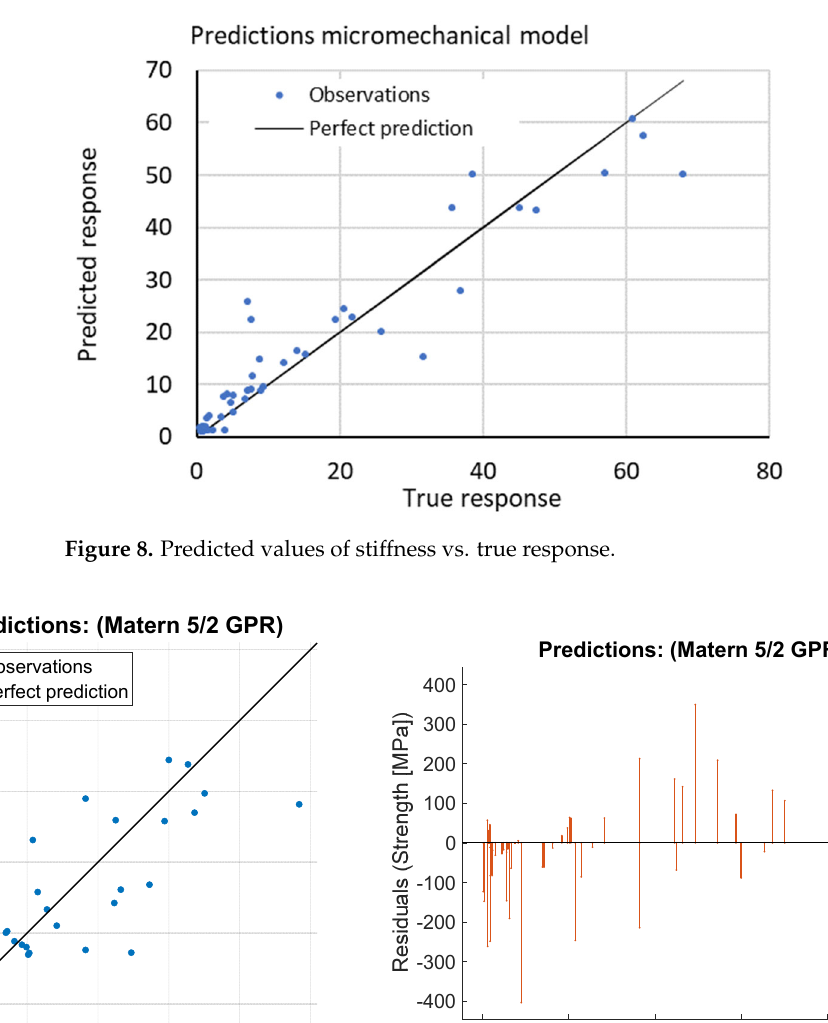
Figure 10. Failure topologies of AM Composites: ( a ) 0° fiber alignment, ( b ) 45°, ( c ) 90°. In the second and third types, Figure 10b,c, for types 45° and 90°, respectively, the specimens did not break into separate pieces, and they suffered extensive deformation that reached the end of the experiment. The failure sequence may be that the failure starts in an intralaminar manner (through the thickness in which only matrix and fiber/matrix interface are broken) and then, interlaminar. In multiple points of the reinforced region, the damage progresses through the nylon, causing plastic deformation with high strains, thus, forming shear bands. We saw a mixture of the two modes for the on ‐ edge printing specimens. In specimens with low reinforcement content, the samples failed mainly by large deformation in the nylon zone and, consequently, the intralaminar failure of the reinforced region. On the other side of the spectrum, the specimens with higher reinforcement content failed by